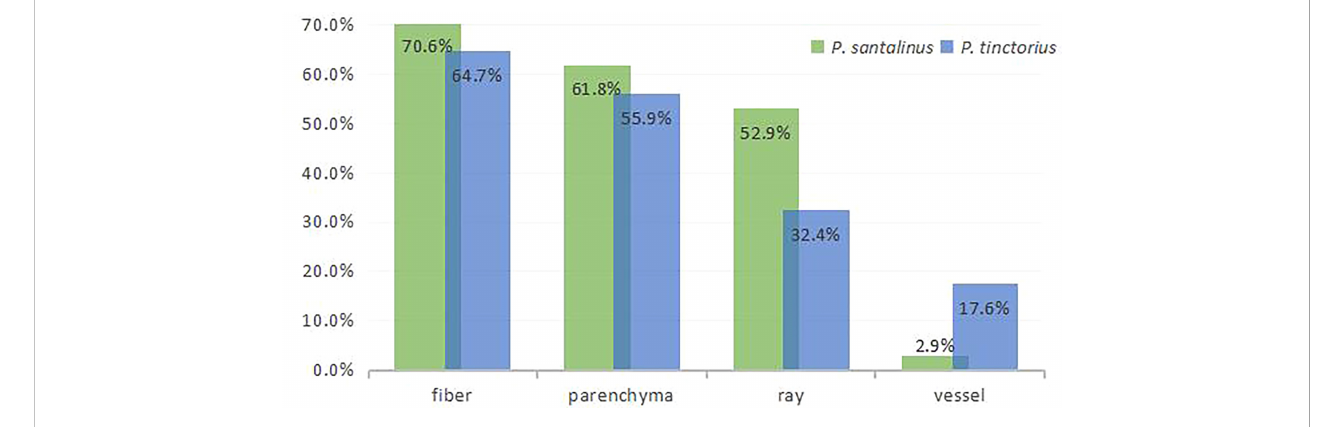
FIGURE 5 Histogram of tissue distribution of metabolites detected by